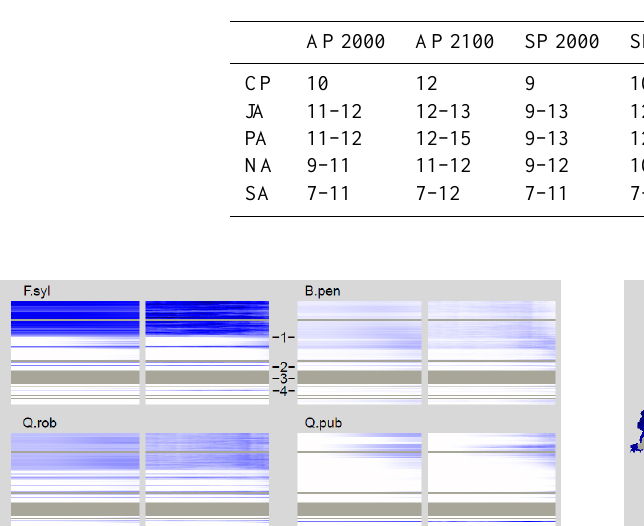
Table 2. Total simulated (rough values) and actual biomass for the years 2000 and 2100. CP: Central Plateau; JA: Jura; PA: Prealps; NA: Central, northwest and northeast Alps; SA: south, southeast and southwest Alps (see Brändli (2009) for the detailed locations of regions); SP: standard parameter set; AP: adjusted parameter set; APS: Forest stock approximated from AP 2000 results (10kgC m − 2 are equivalent to 400m 3 wood ha − 1 ; see Sect. 2.5); NFIS: actual forest stock as result of the newest SWISS national forest inventory (Brändli, 2009). Units of SP and AP are in kilograms of carbon per square meter (kgC m − 2 ). Units of APS and NFIS are in cubic meters of wood per hectare (m 3 wood ha − 1 ).